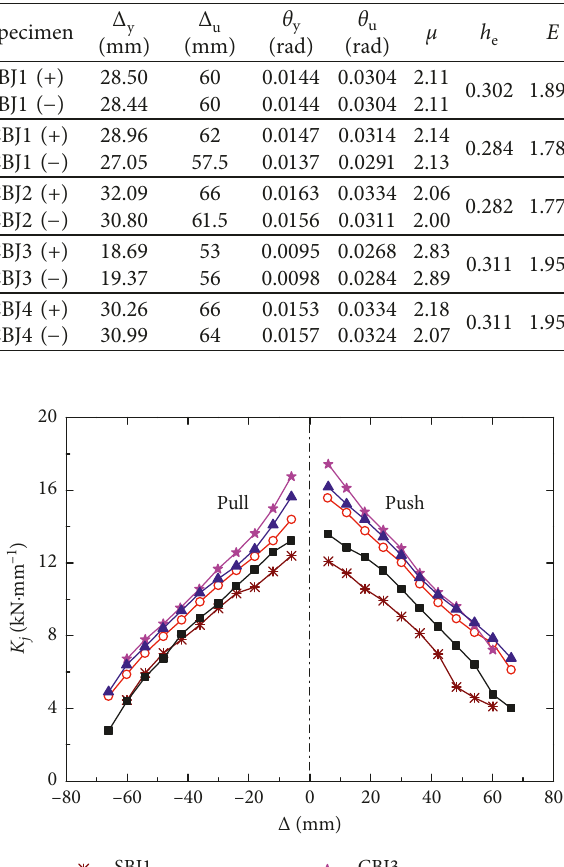
Table 5: Ductility coefficients and energy dissipation of the specimens.